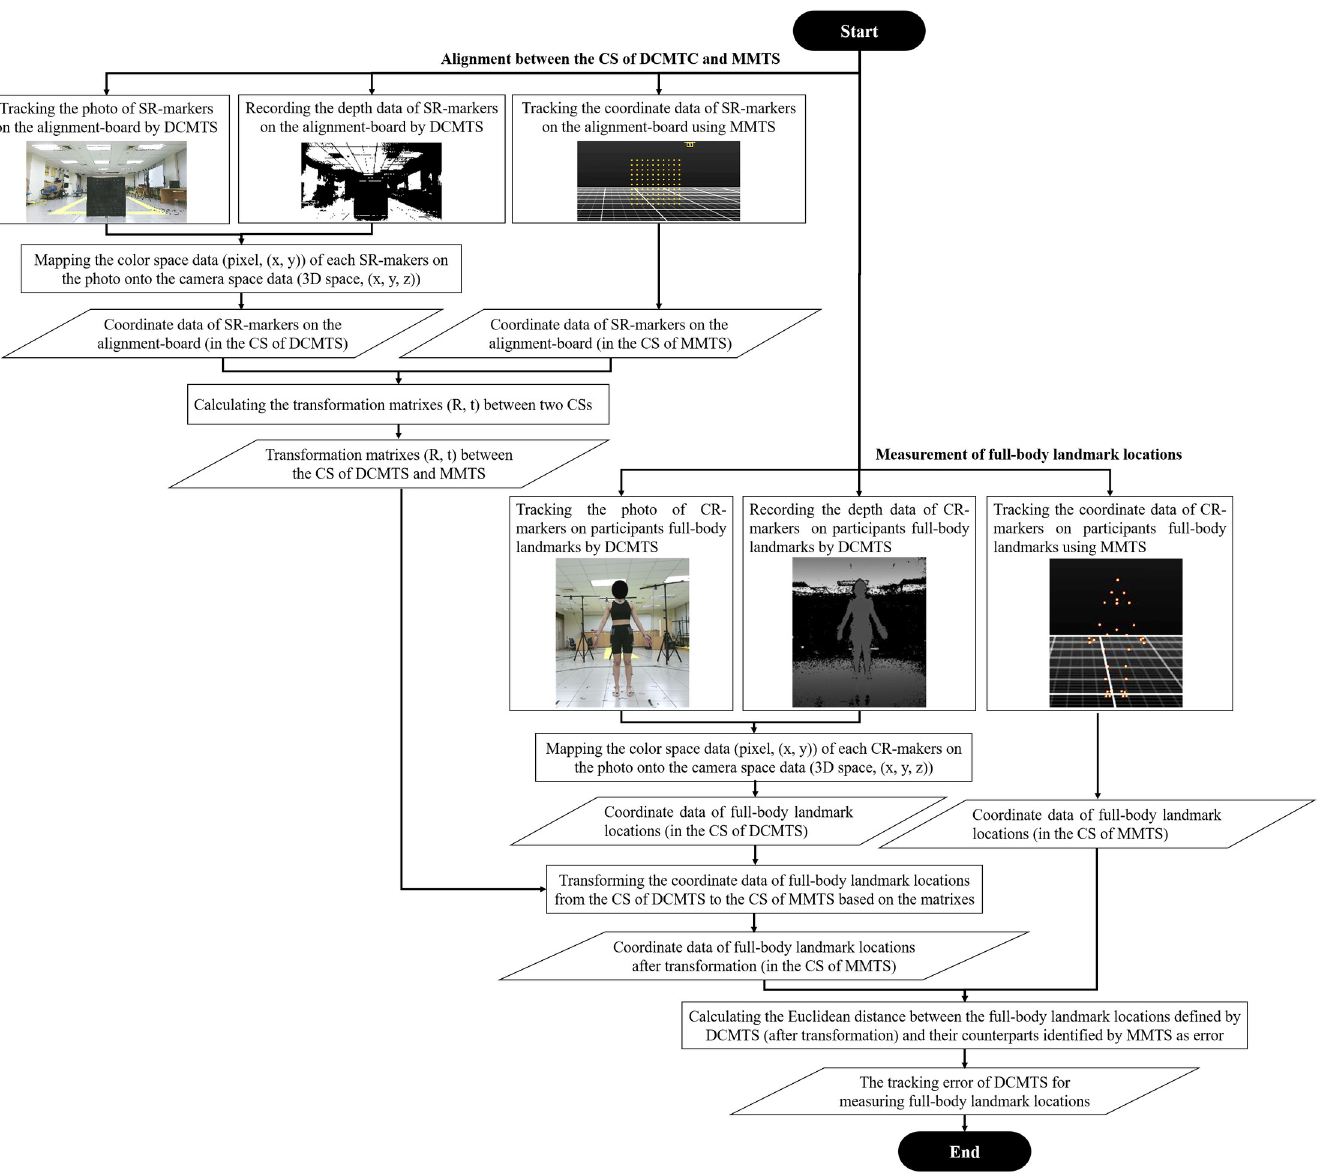
Fig 5. The flowchart for describing the use of the proposed benchmarking method. (MMTS: marker-based motion tracking system; DCMTS: depth camera-based motion tracking system; CS: coordinate system; SR-marker: special reflective marker; CR-marker: custom reflective marker). recording and outputting coordinate data of the markers on the board and participants’ body landmarks. For the RealSense system, this study used Intel RealSense SDK 2.0 to write a pro- gram for obtaining the depth data of the reflective markers from the color picture. The center points of the markers shown on the color pictures were manually selected, and their pixel-coordinate data were determined by an experimenter who performed several trials before formal data acquisition. Next, the color space data (pixel, (x, y)) were mapped onto the camera space (3-D space, (x, y, z)). This manual selection procedure was repeated twice by the experimenter based on the same dataset.